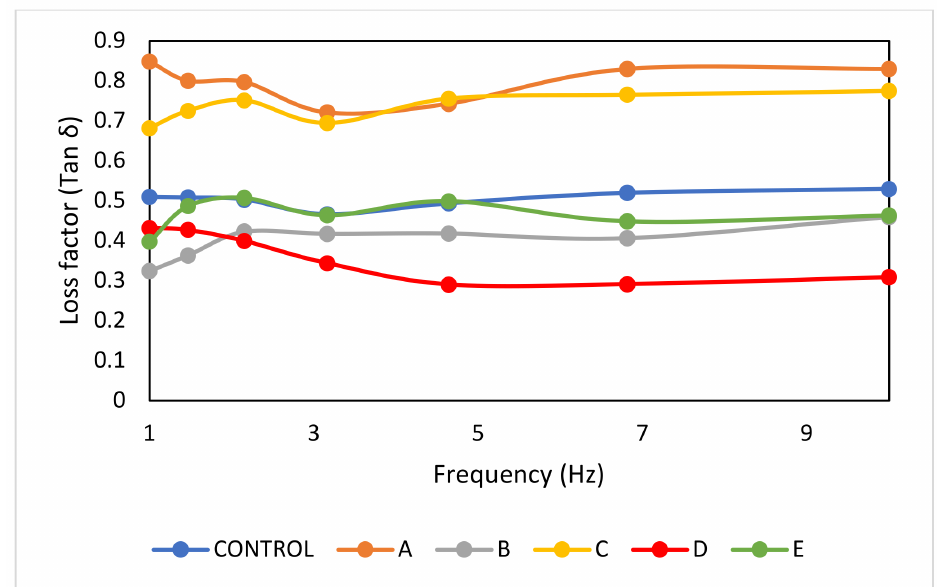
Figure 3. Loss factor (tan δ ) of fat-replaced samples with palm shortenings (PS) of various melting ranges (MR) as compared to the control sample with chicken skin. Control (chicken skin), sample A (PS at MR of 33–36 ◦ C), sample B (PS at MR of 38–42 ◦ C), sample C (PS at MR of 44–46 ◦ C), sample D (PS at MR of 45–49 ◦ C), and sample E (PS at MR of 55–60 ◦